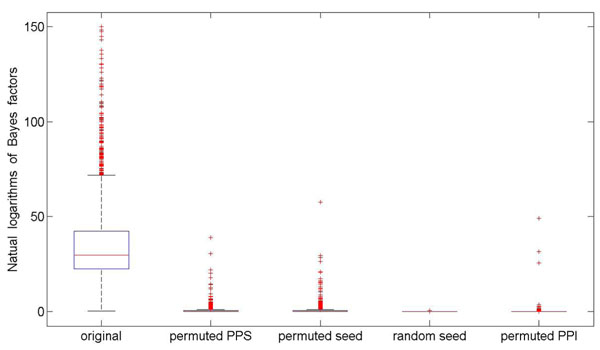
Bayes factors of the original and permuted data. “original”, “permuted PPS”, “permuted seed”, “random seed”, “permuted PPI” denote the results obtained using original data, permuting phenotype similarity profile, permuting disease-gene associations, replacing disease genes in disease-gene associations with randomly selected genes, and permuting connections in the protein-protein interaction network, respectively.